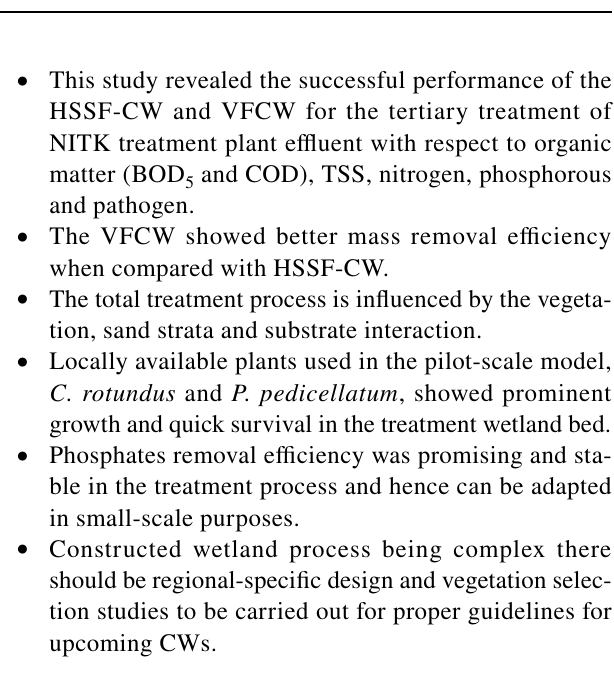
measurement during the operational period of pilot-scale VFCW from February 14, 2018, to May 15, 2018 (vegetation cutting was carried out at the end of April 2nd week)